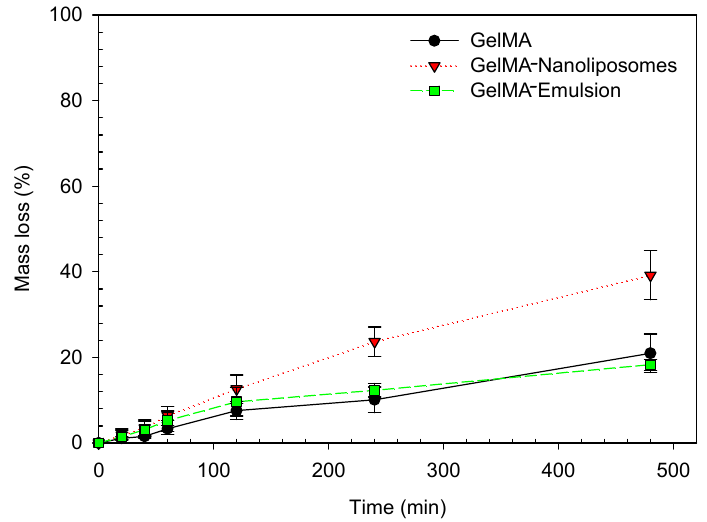
Figure 4. GelMA degradability GelMA ( ● ), GelMA-Nanoliposomes ( ▼ ), and GelMA-Emulsion ( ■ ) hydrogels of uniform size were exposed to 2 µg/mL exogenous collagenase. Mass losses (%) were measured during 8 h. Error bars represent standard deviation